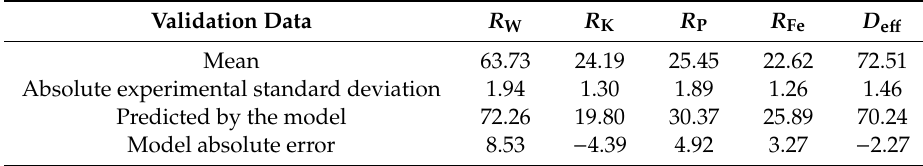
Table 6. Validation test for the Falcon UF based on a test with optimized parameters ( ω = 70 Hz; % S = 2 wt %; Q = 3 kg · min − 1 ) repeated four